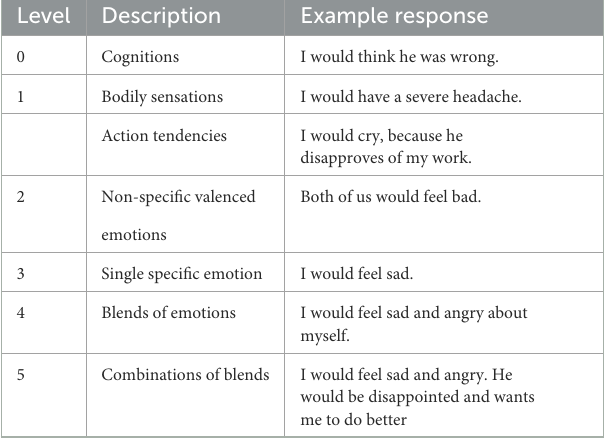
TABLE 2 The five levels of emotional awareness